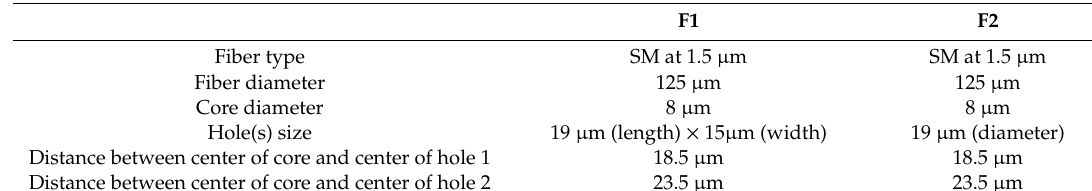
Figure 1. Three-dimensional (3D) transparent schematic of the new double-hole fiber. Table 1. Parameters of the models.